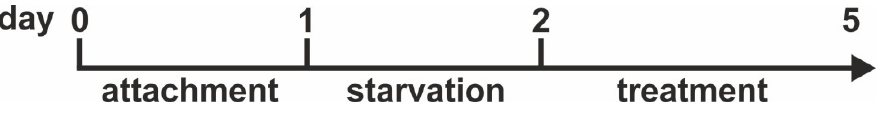
Figure 1. Consecutive cultivation conditions of hCSCs in the microfluidic cultivation